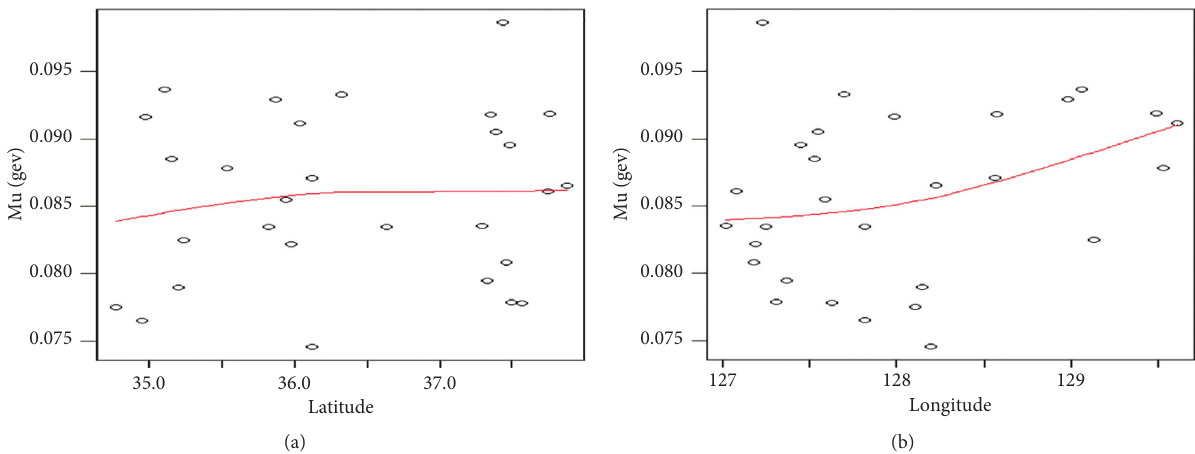
Figure 4: The relation between the location parameter of the spatial GEV model and the covariates latitude and longitude.